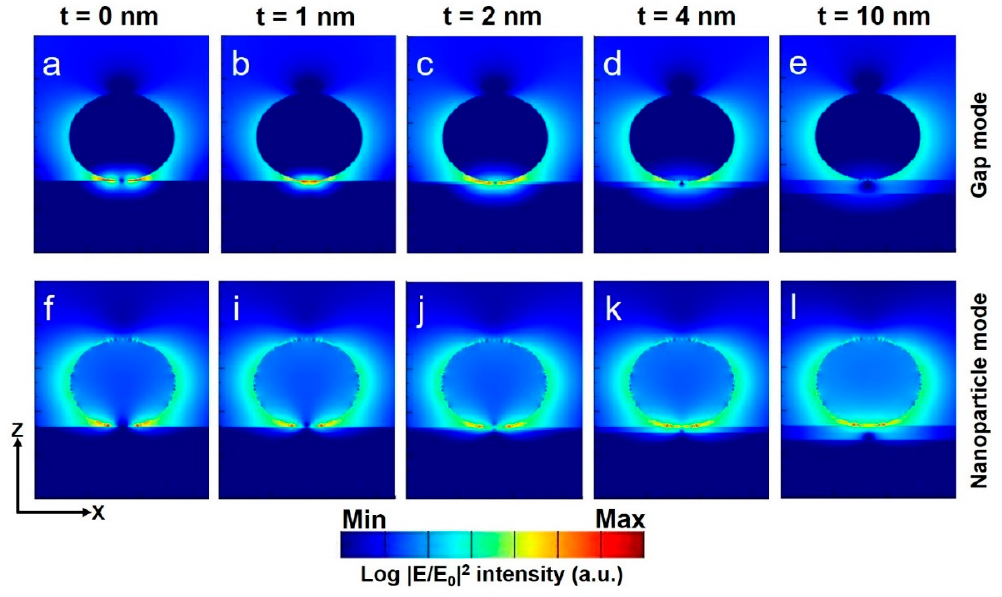
Figure 3. Cross-sectional ( XZ ) electric field amplitude profiles obtained from the peak resonances of gap modes ( a – e ) and nanoparticle modes ( f – l ) as a function of dielectric layer thickness “ t ”. The color ranges are in log scale.